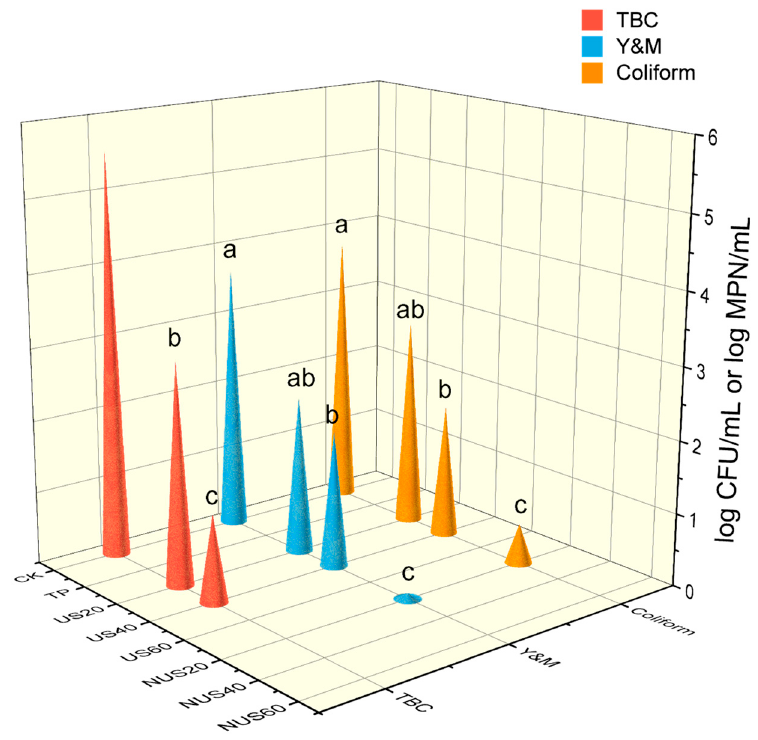
Figure 4. The effects of different sterilisation treatments on microorganism load in chestnut lily beverages. CK represents the untreated group; TP represents the heat treatment group; US20, 40, and 60 represent the ultrasonic treatment alone groups for 20, 40, and 60 min; and NUS20, 40, and 60 represent the ultrasonic combined nisin treatment groups for 20, 40, and 60 min. The Escherichia coli results are expressed as log MPN/mL, while the other results were expressed as log CFU/mL. Values with different letters (a, b, and c) are significantly different from one another ( p < 0.05).